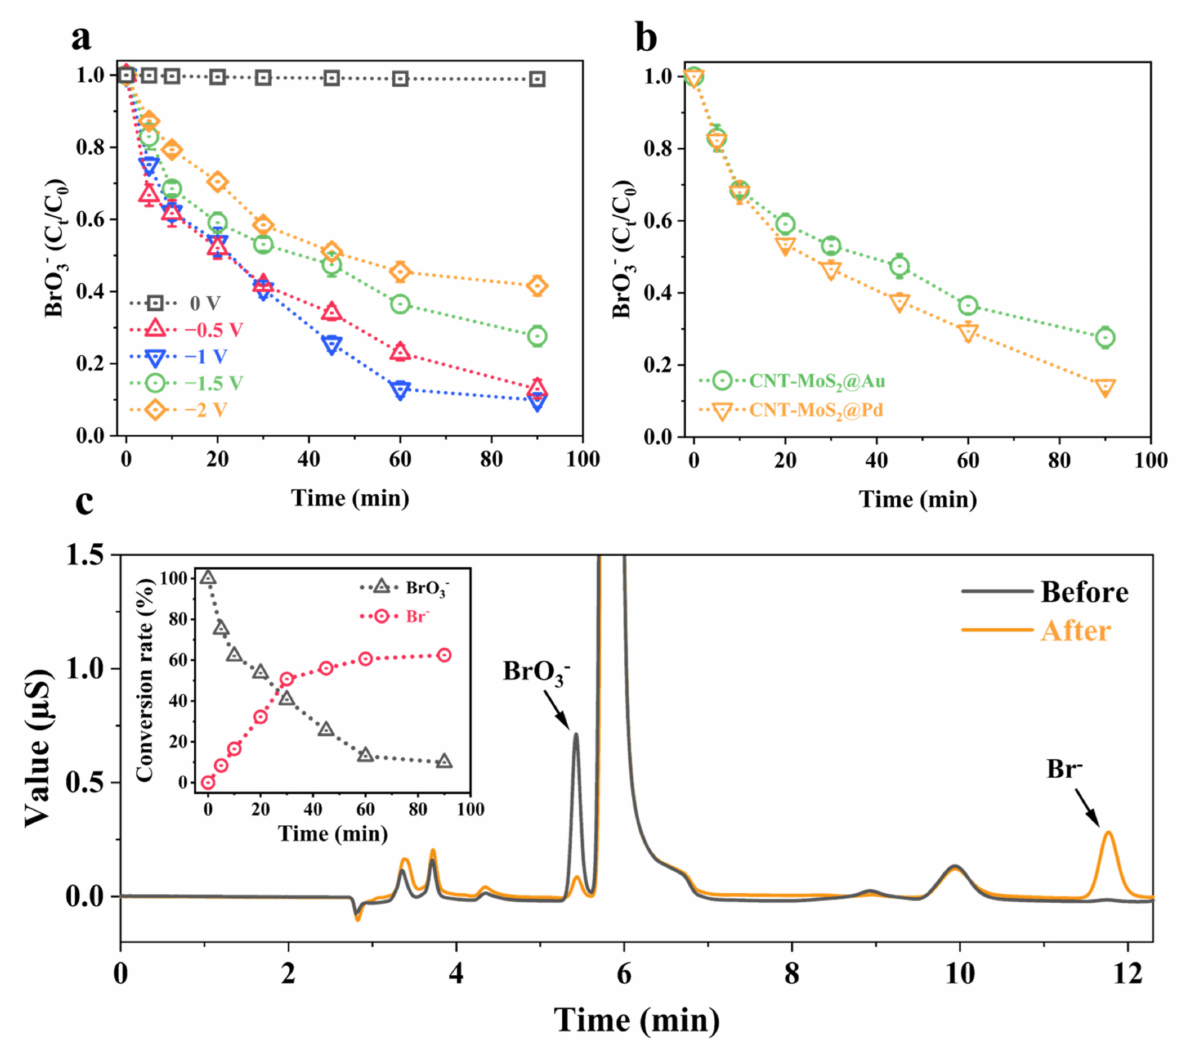
Figure 4. ( a ) Effect of applied potential (0 to − 1.5 V) on BrO 3 − reduction using the CNT-MoS 2 @Au catalytic membrane. ( b ) Comparison of effects on BrO 3 − reduction using different catalytic mem- brane. ( c ) IC spectra of the BrO 3 − solution before and after the electrocatalytic treatment. Inset is a comparation of the conversion efficiency towards BrO 3 − and Br − within 90